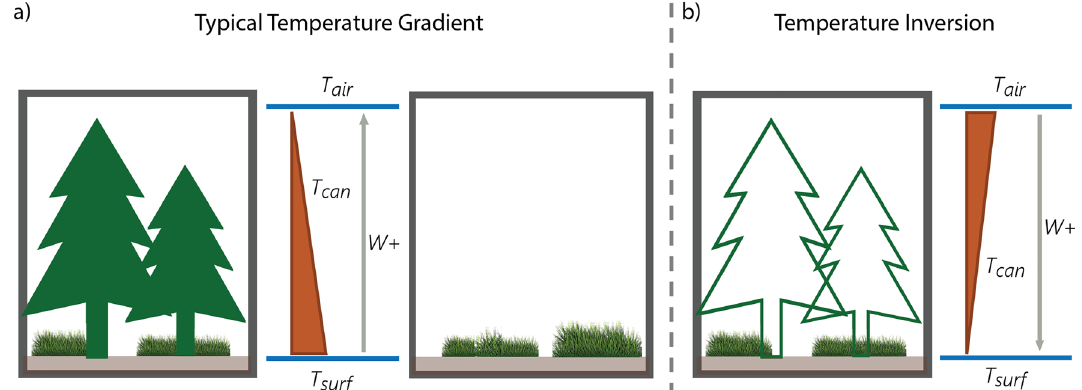
Figure 1. Conceptual diagram of temperature gradients. The W+ arrow indicates the positive direction of work performed through heat transport. Although in different directions, in both cases ( a ) and ( b ), the work performed is positive because heat moves from high to low temperatures. ( a ) Typical summertime temperature gradients from the earth surface to the air above the canopy are negative for the two real scenarios: subalpine/ sub-Arctic forest ( left ) and alpine tundra/Arctic meadow ( right ). ( b ) A conceptual temperature inversion, or positive temperature gradient, which arise when alpine/Arctic forest are simulated as